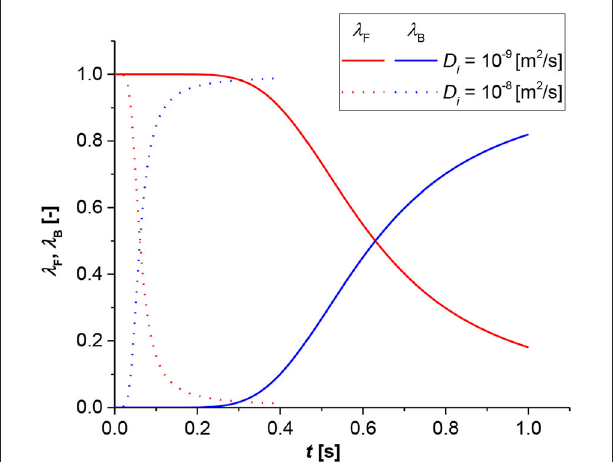
FIGURE 5 | Contribution analysis results for bulk (blue lines) and film (red lines). Simulation conditions R 0 = 1 × 10 − 3 [m], k = 1 × 10 − 3 [m 3 /(mol s)], K eq = 1 × 10 − 3 [-].